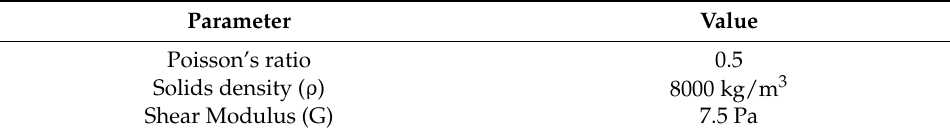
Table 5. Additional parameters for particle-geometry